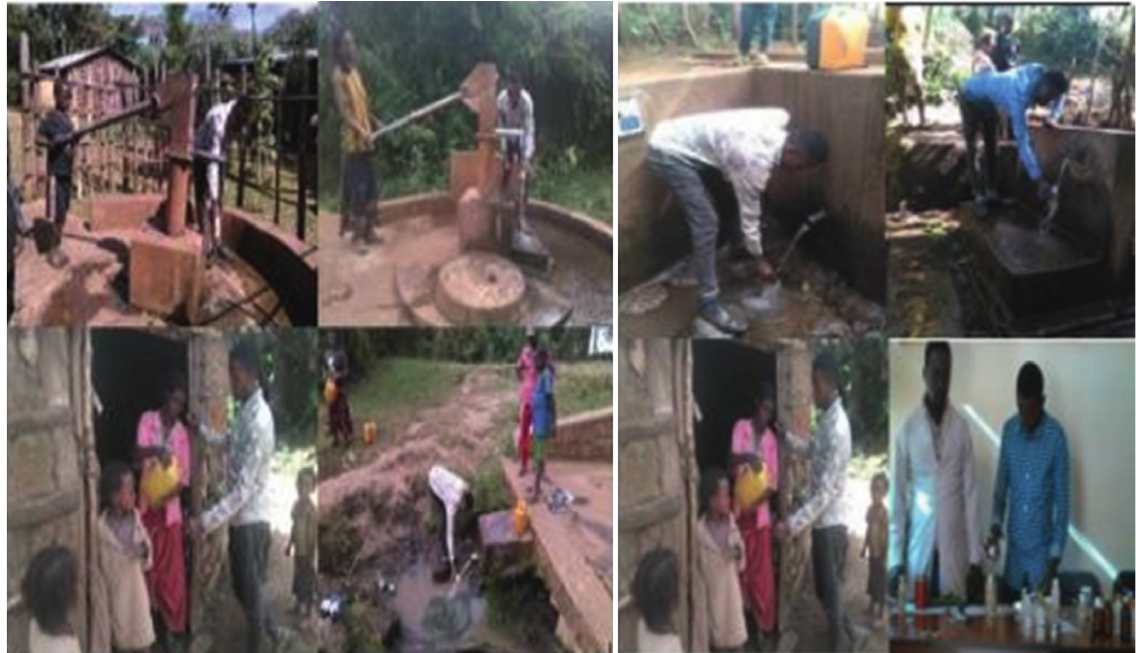
Thermo-tolerant (faecal) coliforms colonies appear as purple dots and total coliforms as pink dots using Coli scan broth. Figure 1: Different indicator bacteria colonies. (a) Thermotolerant (faecal) coliform colonies appear as purple dots and total coliforms as pink dots using Coliscan broth. (b) E. coli colonies appear as blue dots using m-Coli blue broth. The red dots indicate total coliform colonies.